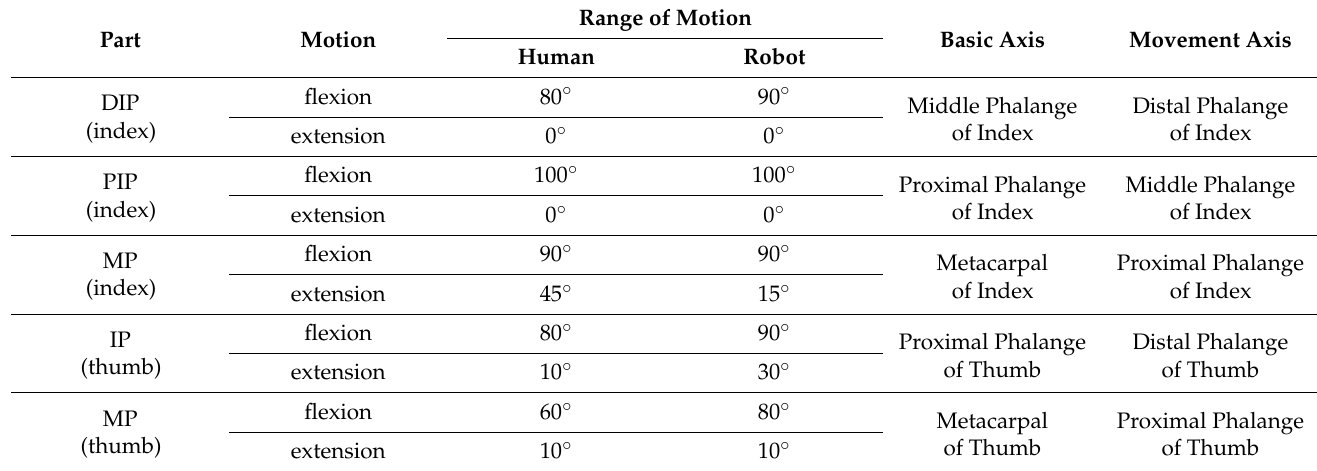
Table 2. Range of motion between human and prosthetic